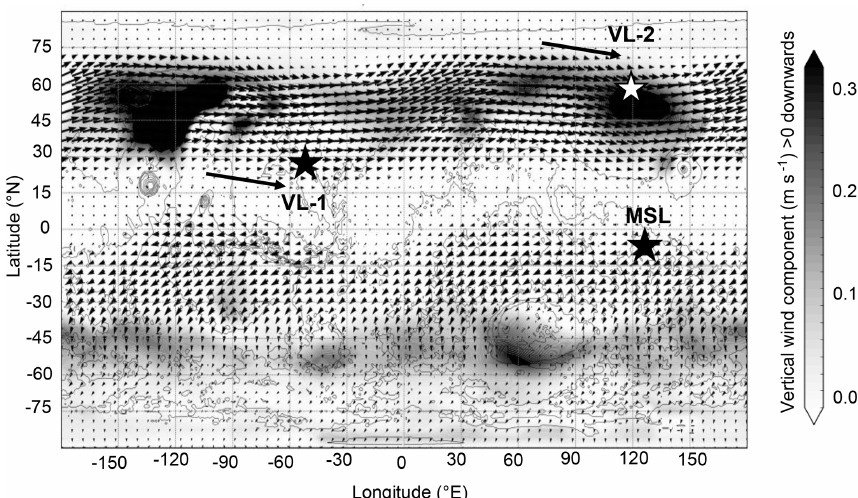
Figure 7. MCD vertical velocity w and horizontal winds at an altitude of 20km at an areocentric longitude of L S = 270 ◦ . The convention used here is opposite to the one we used in Sect. 3.1. Note, to make visualisation of the downwelling regions clearer only the positive downwelling velocity is shown. Any negative velocities are white. The long arrows next to the VL-1 and VL-2 sites represent the direction of the winds immediately to the west of those